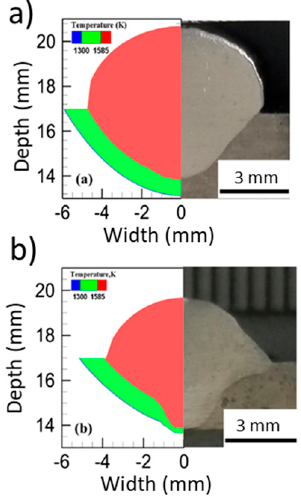
Figure 28. Comparison between predicted and experimental bead cross section for a travel speed of: ( a ) 5 mm/s and ( b ) 8.3 mm/s. (adapted from [137]).